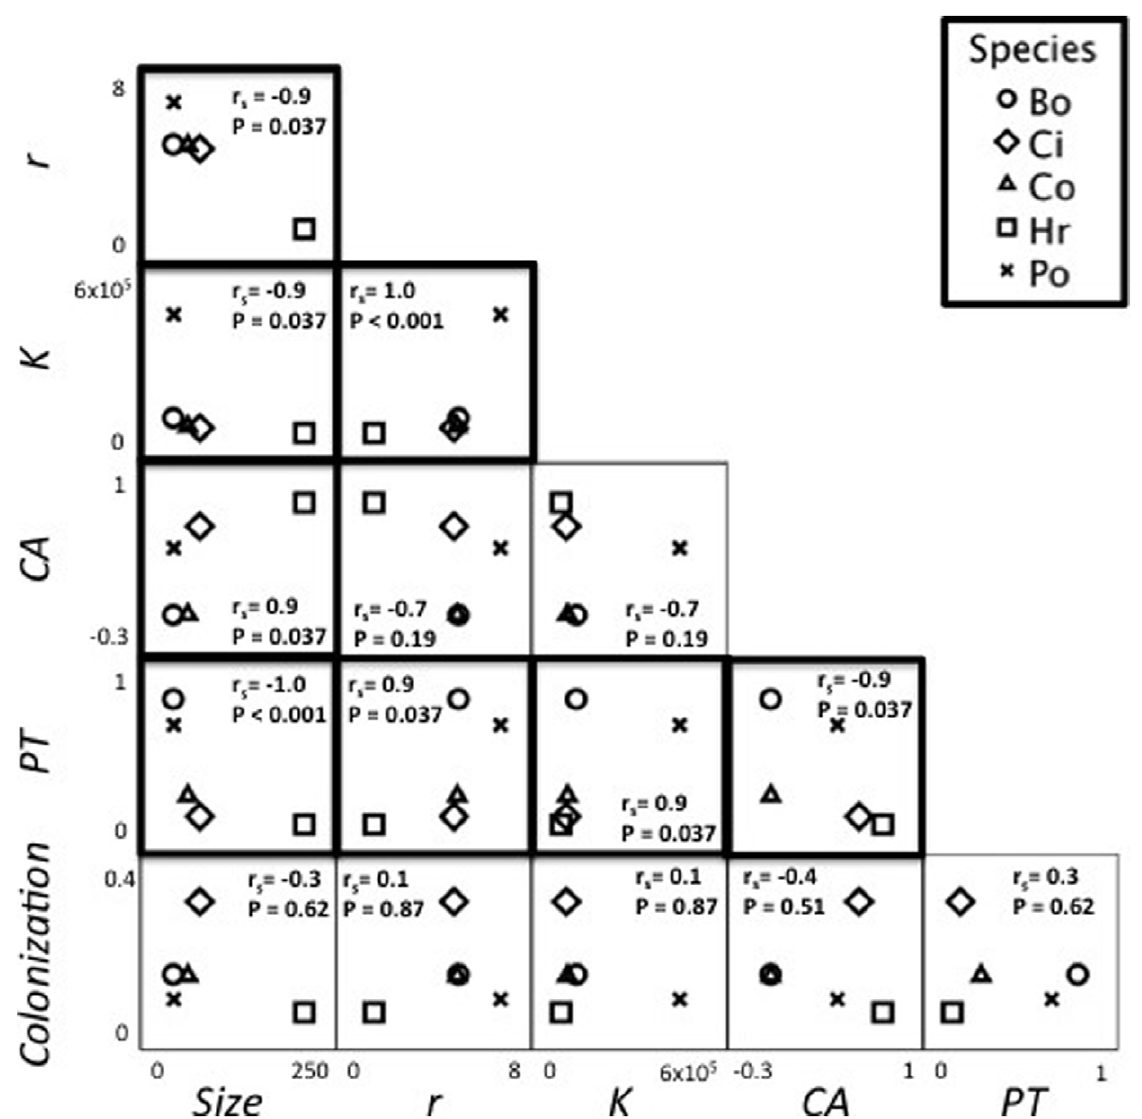
Figure 2. Scatterplots of measured species’ traits (Competitive Ability [CA], Predator Tolerance [PT], Colonization Rate [Colonization], Size, Growth rate [r], and Carrying capacity [K]). Bold borders indicate a significant relationship ( P , 0.05) from Spearman rank correlation, see Results for details. Correlations with competitive ability and predator tolerance address the local scale, and those including colonization address the regional scale. Species abbreviations are: Bo, Bodo sp.; Po, Poterioochromonas sp.; Ci, Colpidium sp.; Co, Colpoda sp.; Hr, Habrotrocha rosa . doi:10.1371/journal.pone.0041809.g002 A strong negative correlation was found between predator tolerance and competitive ability (Figure 2). Species less affected by predators (i.e. Bodo sp. and Poterioochromonas sp.) were weaker competitors, while the better competitors (i.e. H. rosa and Colpidium sp.) were strongly suppressed by predators. There was no (Figure 2). Body size, population growth rate, and carrying capacity were examined in relation to each other (Table 1, Figure 2). Body size was negatively correlated with population growth rate (r s = 2 0.9, P = 0.037) and carrying capacity (r s = 2 0.9, P = 0.037); growth rate was positively correlated with carrying capacity (r s = 1.0, P , 0.001). These traits were also correlated with the traits associated with trade-offs.